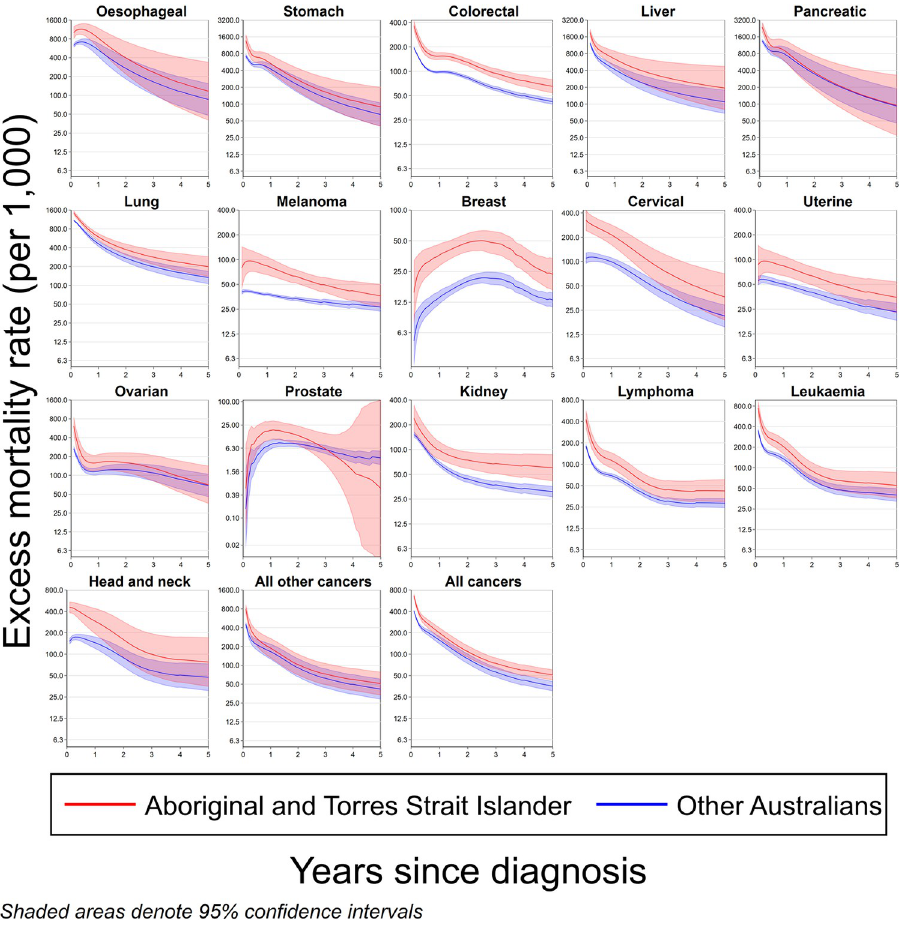
Fig 1. Excess mortality rate from all causes, up to five years since diagnosis by cancer type and Australian Indigenous status, Australia, 2005–2016.